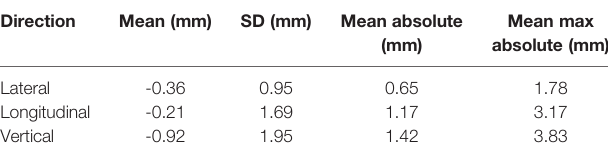
TABLE 2 | Mean, standard deviation (SD), mean absolute, and mean max absolute of the real prostate translational data from all the 56 fractions with no interruptions and patient position